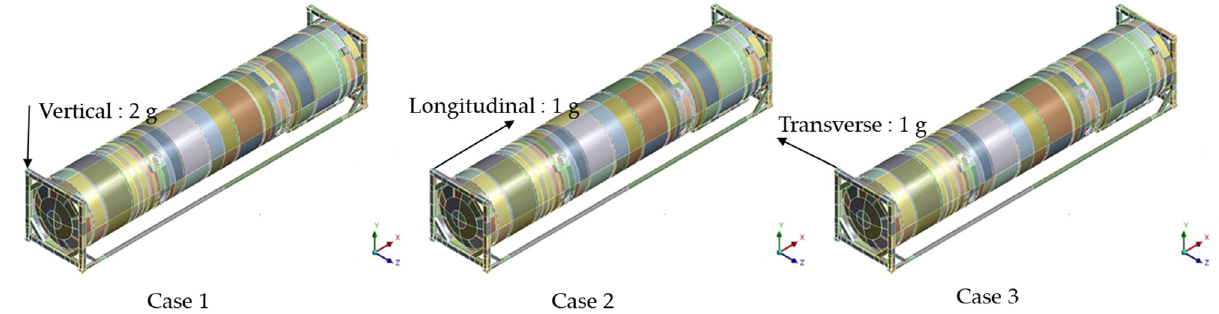
Figure 4. Illustrations of the acceleration locations during high-cycle loading conditions for simu- lation cases 1, 2 and